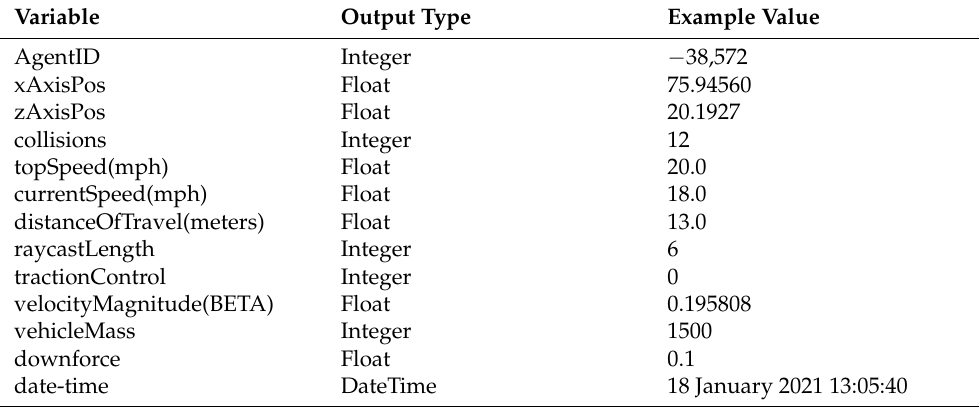
Table 2. Model output variables, source